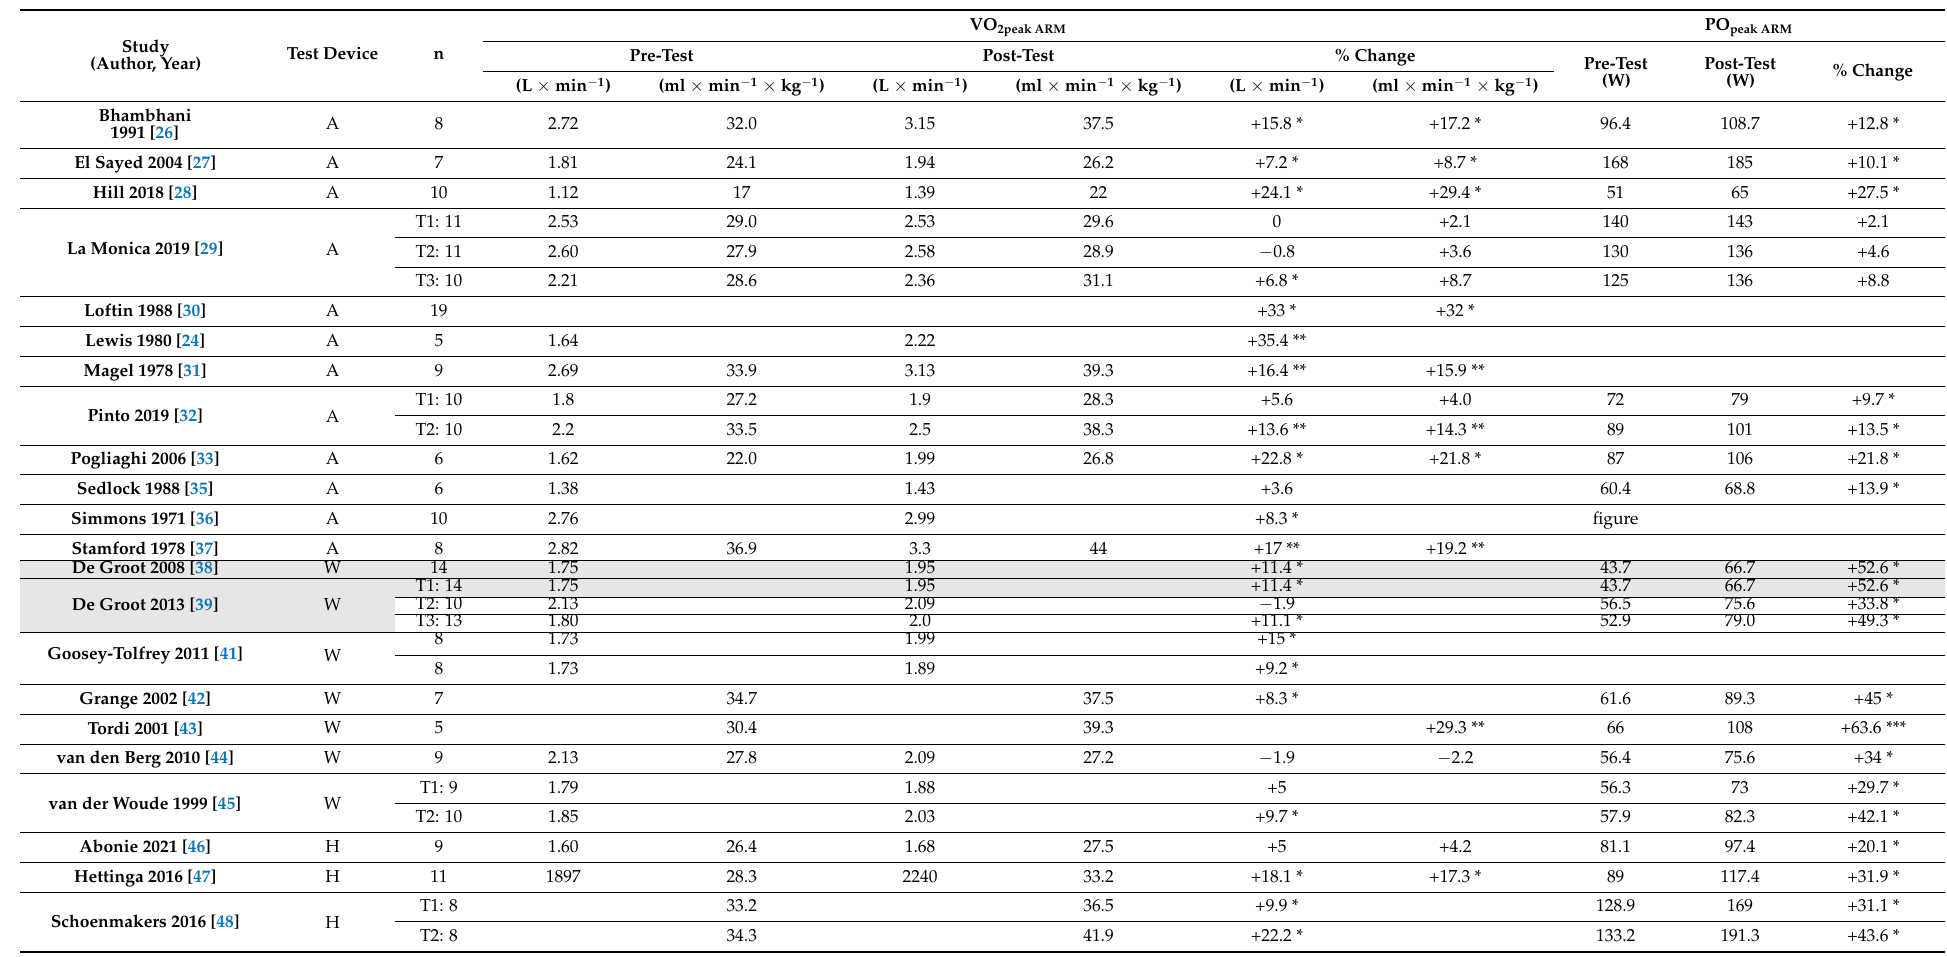
Table 4. Mean change in VO 2peak ARM and PO peak ARM between pre- and